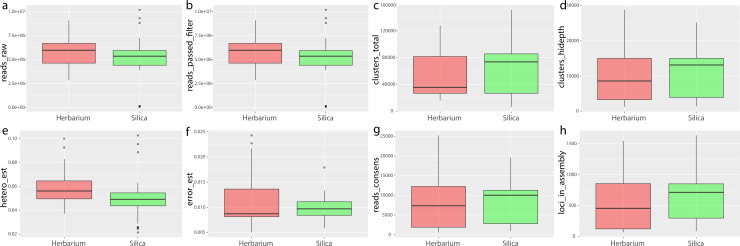
Box plot comparisons of herbarium and silica sample characteristics for statistics derived from ipyrad analyses.Herbarium material: left, red; silica materials: right, green (see also S6 Fig).